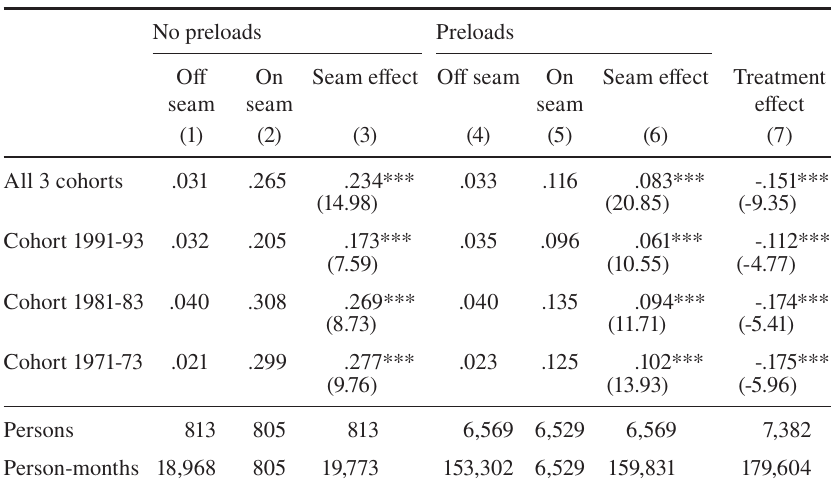
Table 1 Proportion of respondents reporting a change of status compared to the previous month by treatment group and estimated seam effects with and without using preloads No